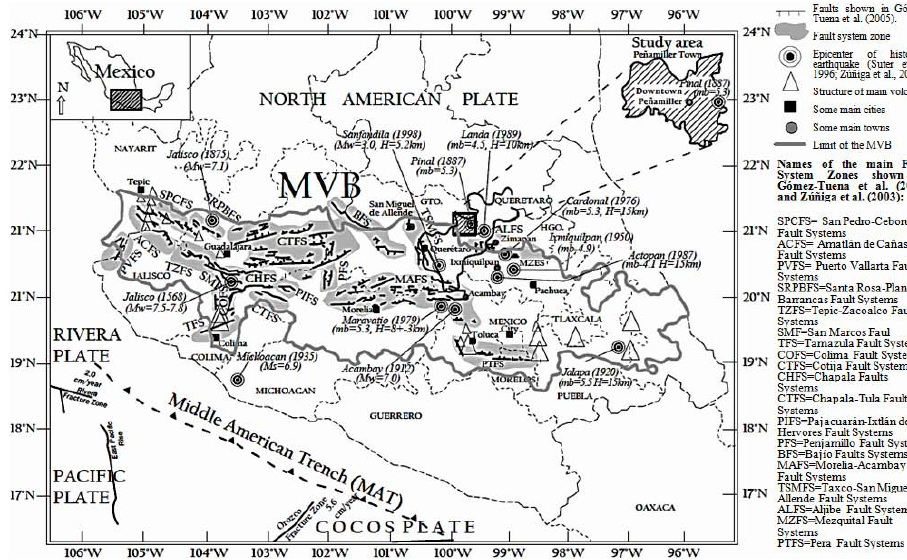
Fig. 1. Regional tectonic situation, main fault systems zones, historical large earthquakes of the MVB and study area.